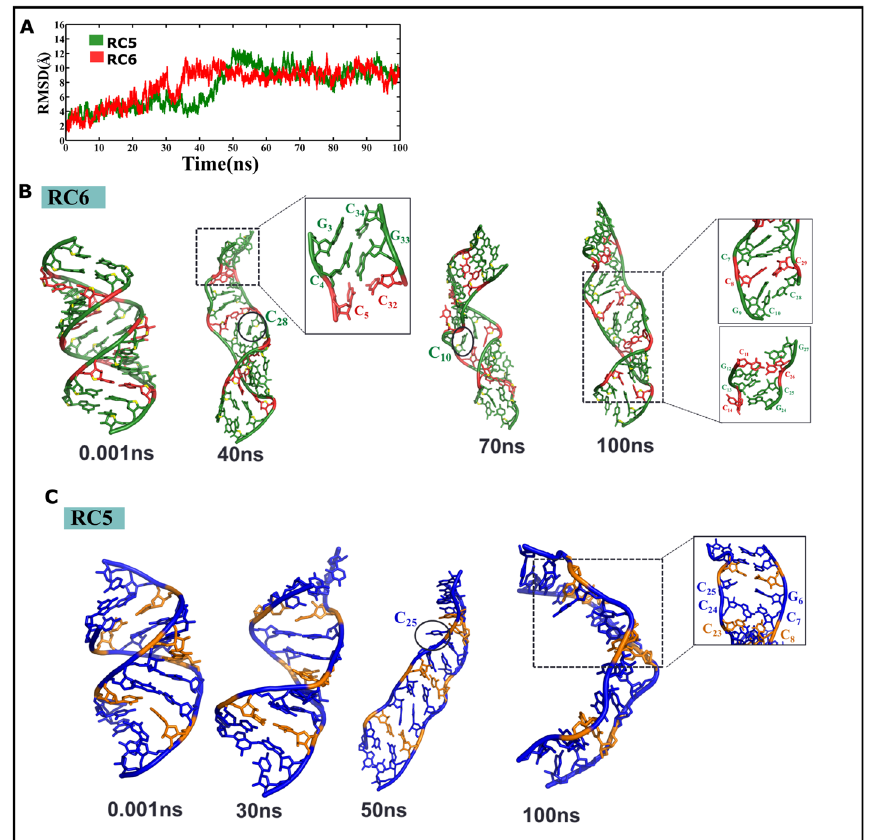
Figure 2. Schemes RC6 and RC5 that contain 6 & 5 C…C mismatches respectively, exhibit distortions in the double helix. ( A ) Time vs. RMSD profile showing significant conformational changes in RC6 (red color) and RC5 (green color) as indicated by a high RMSD value. This figure was plotted by using MATLAB 7.11.0 software (www. mathw orks. com). ( B , C ) Snapshots illustrating the distortions in the double helix caused by the conformational rearrangement of C…C mismatches in RC6 ( B ) and RC5 ( C ). Note that the unpaired cytosines are shown in circles. This figure was generated by using pymol 1.3 (www. pymol.